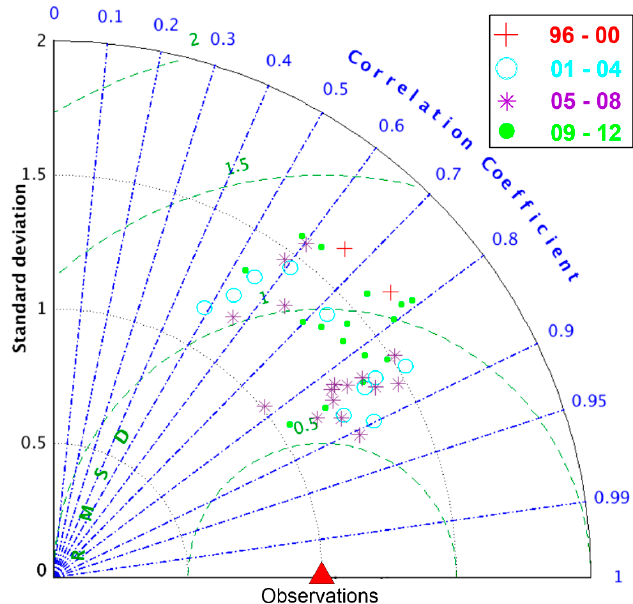
Figure 5. Taylor diagram for observed and modeled annual sea-level anomaly at four tidal stations from 1996 to 2012. Radial distance represents the ratio of simulated to observed standard deviations, and azimuthal angle represents model–data correlation. Green arcs represent centered root mean square difference between model and measurements. To facilitate the comparison of model results and observations, annual sea level comparisons in certain years are represented by the same symbol (red plus for years 1996, 1997, 1998, 1999, and 2000; cyan circle for 2001, 2002, 2003, and 2004; purple asterisk for 2005, 2006, 2007, and 2008; green dot for 2009, 2010, 2011, and 2012). Each dot represents one single station for a single year. The locations of stations are shown in Figure 1 (red dot). Both observations and simulations are collected every hour.